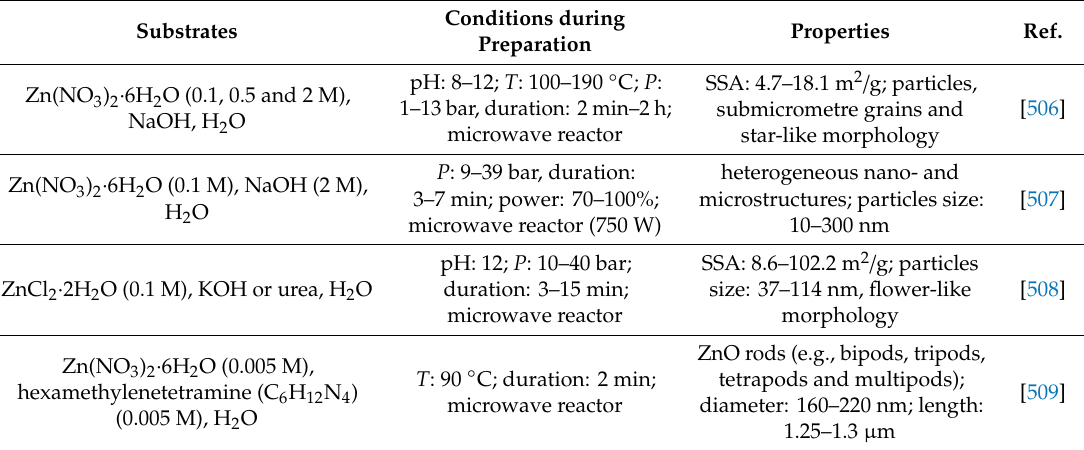
Table 5. Summary of microwave hydrothermal synthesis of ZnO without any additional heat treatment. SSA: specific surface